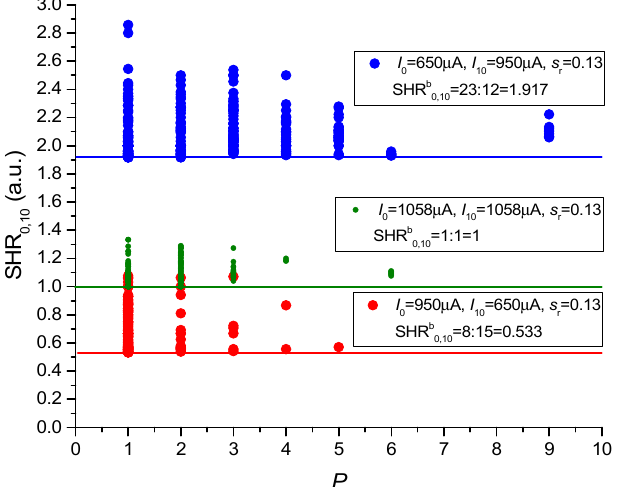
Figure 19. Distribution of synchronization values SHR 0,10 at random variations of coupling strengths ( s o, s m ) and currents ( I ON , I OFF ). Fixed parameters are shown in the plot. The base sync value (SHR b 0,10 ) is shown by a solid line. SHR b 0,10 is the sync value at s o =